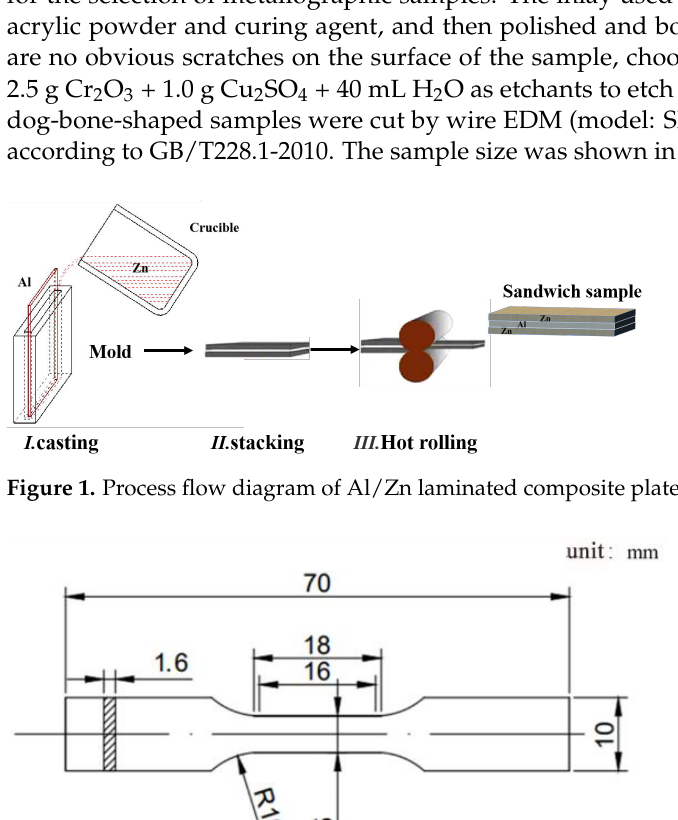
Figure 2. Schematic of the tensile test specimen.